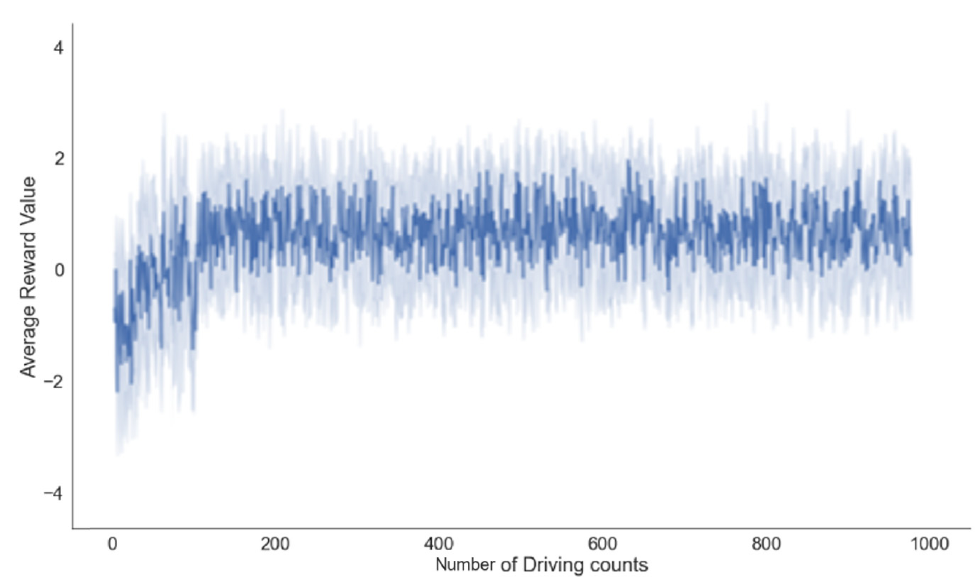
Figure 10. The average reward for 10,000 episodes.